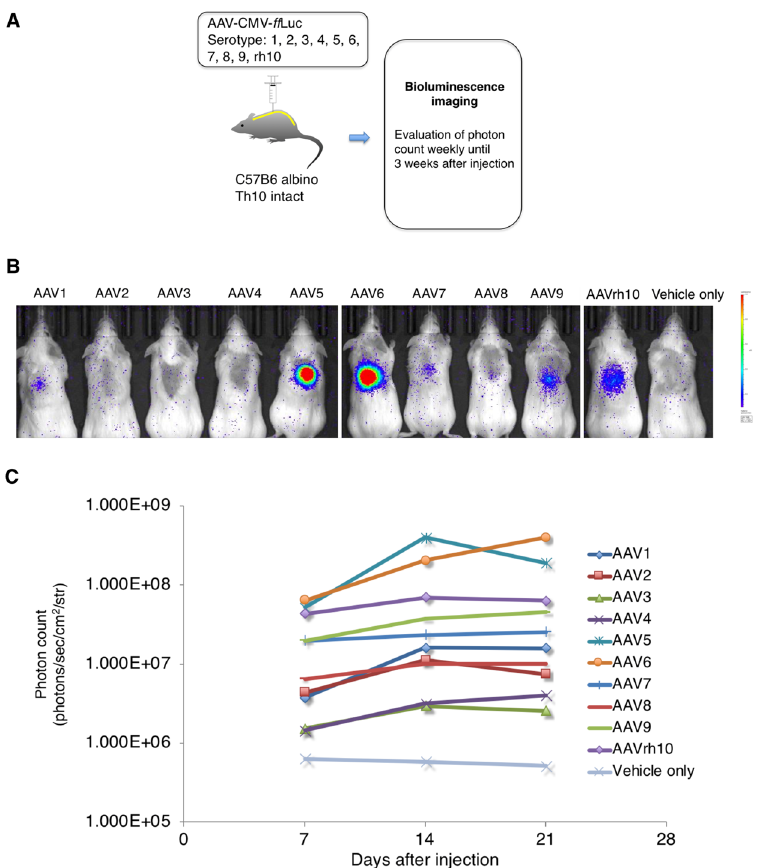
Figure 2. Efficient transduction of the intact mouse spinal cord by AAV1-9 and AAVrh10. ( A ) Schematic diagram of AAV- ff Luc injections into the intact spinal cord. AAV- ff Luc serotypes 1-9, and rh10 were injected into intact mouse spinal cords to validate and evaluate gene expression in vivo . A mouse injected with vehicle only was used as a negative control. ( B ) Representative in vivo BLI of a mouse at 3 weeks post injection of AAV- ff Luc. ( C ) Photon counts from in vivo BLI derived from AAV- ff Luc until 3 weeks post